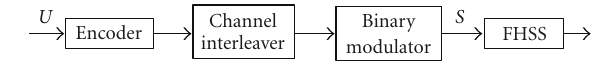
Figure 1: Block diagram of a coded FHSS